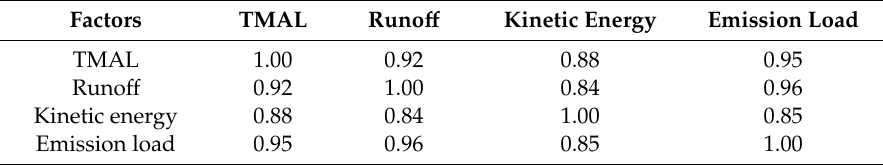
Figure 9. Linear correlations between ( a ) runoff, ( b ) kinetic energy, and ( c ) emission load and TMAL in 2013; ( d ) discrete degrees of scattered data of TMAL, runoff, kinetic energy, and emission load. Table 1. Spearman values between TMAL (total maximum allocated load), runoff, kinetic energy, and emission load.